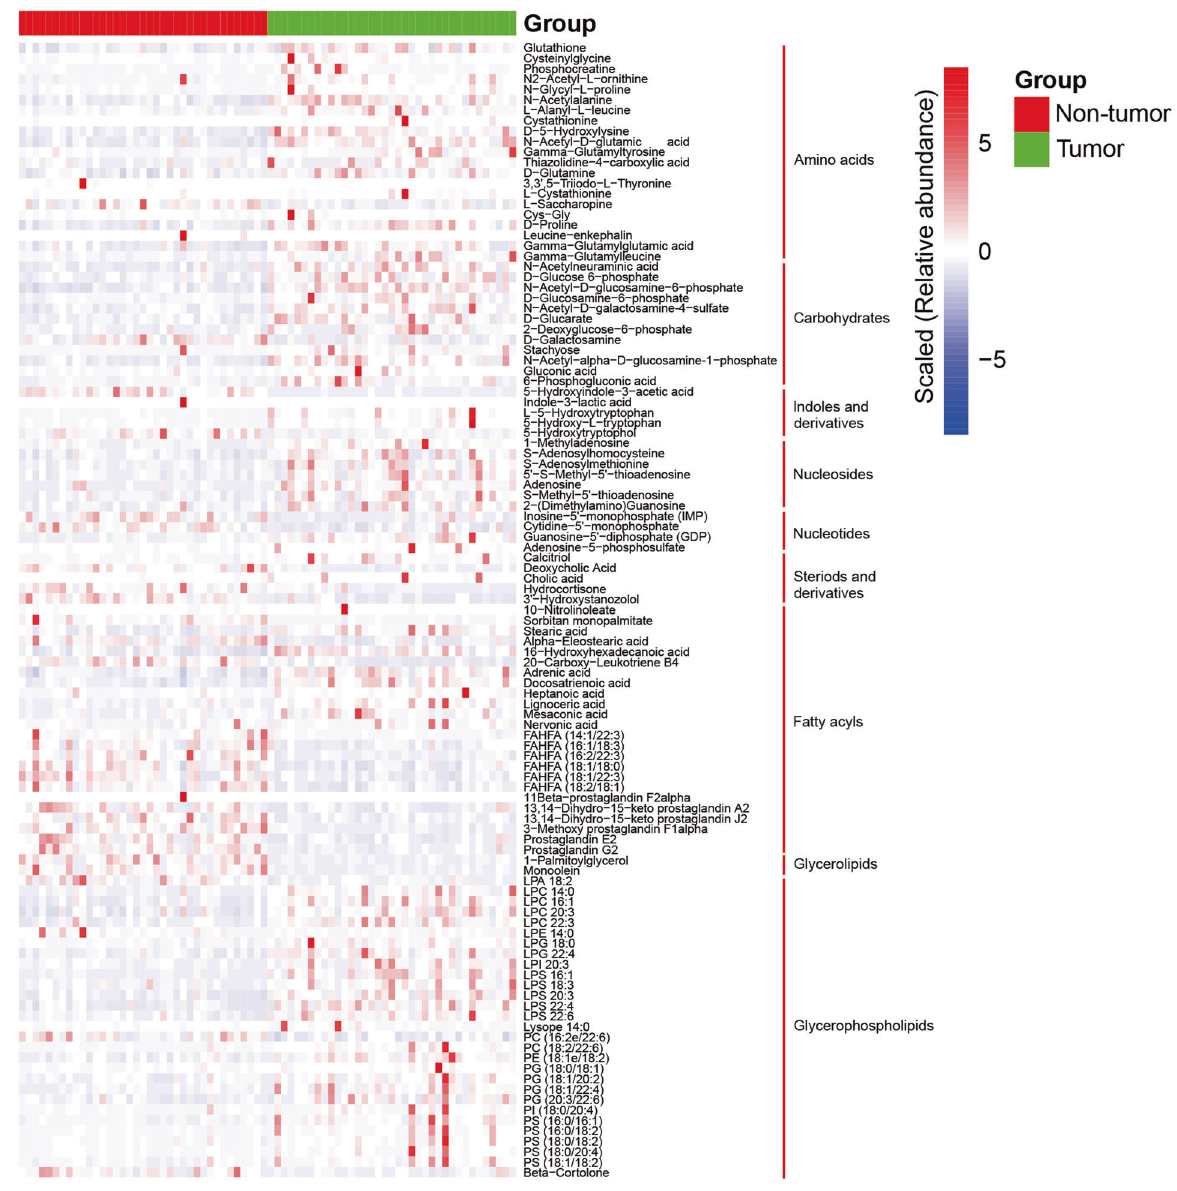
Fig. 3 The heat map shows the differential metabolites between the paired gastric cancer tissues and non-tumor tissues. The heat map shows the scaled relative abundance (Lg) of 109 differential metabolites (VIP > 1 and Q value < 0.05 and fold change (FC) ≥ 2 or FC ≤ 0.5). The discriminative metabolites from top to bottom are amino acids, carbohydrates and carbohydrate conjugates, indoles and derivatives, nucleosides, nucleotides, steroids and derivatives, fatty acyls, glycerolipids, and glycerophospholipids. The differential metabolites were classi fi ed using the Human Metabolome Database. Q value, corrected P